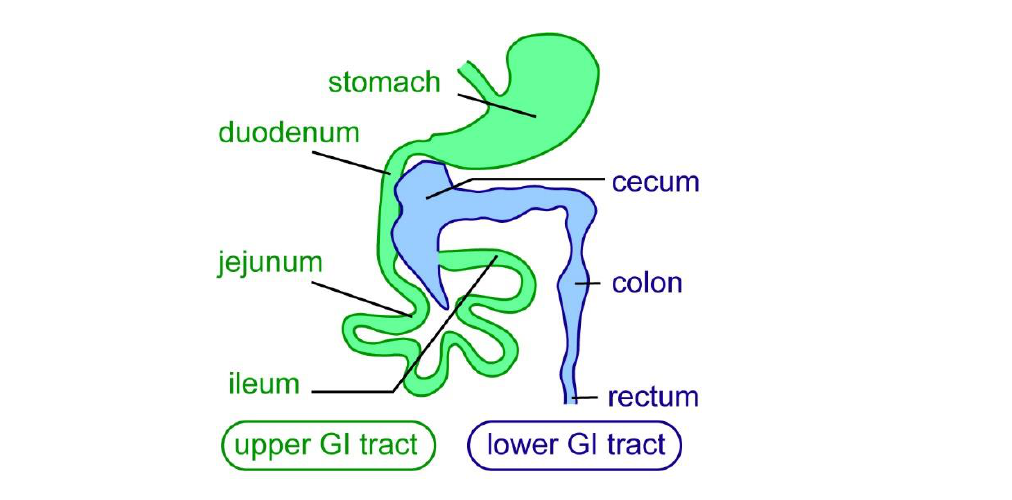
Figure 1. Subdivisions of the mammalian gastrointestinal tract. In mammals the gastrointestinal (GI) tract, here exemplified in mice, is divided into an upper (green) and a lower GI tract (blue). The upper GI tract consist of duodenum, jejunum, and ileum. The lower GI tract consists of the cecum, colon, and rectum [10].